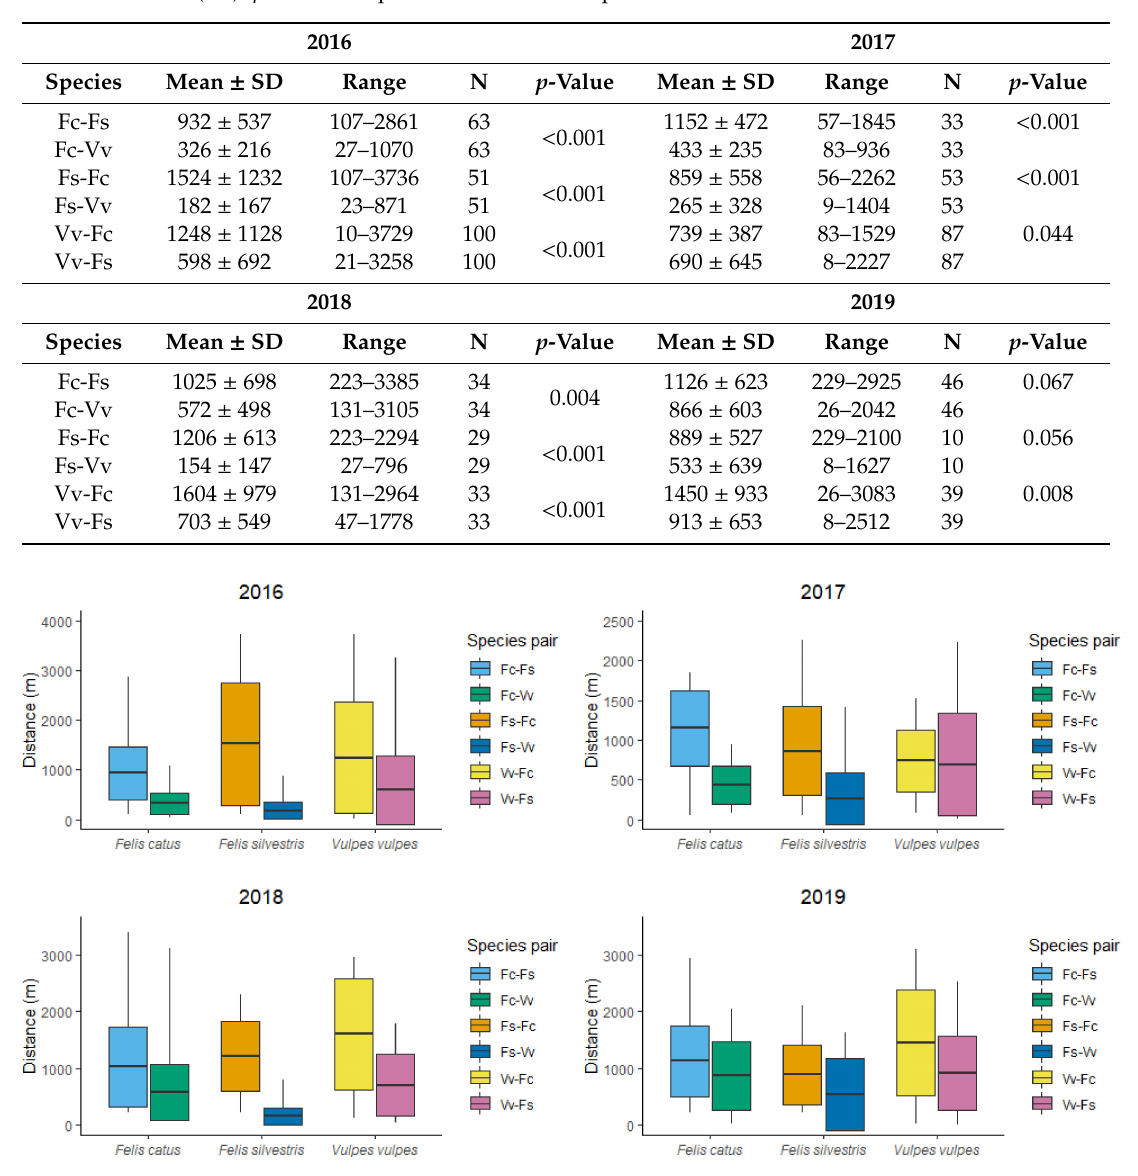
Figure 4. Mean closest distance between species observed in pastures. The boxes represent Mean ± SD and the lines represent the ranges of